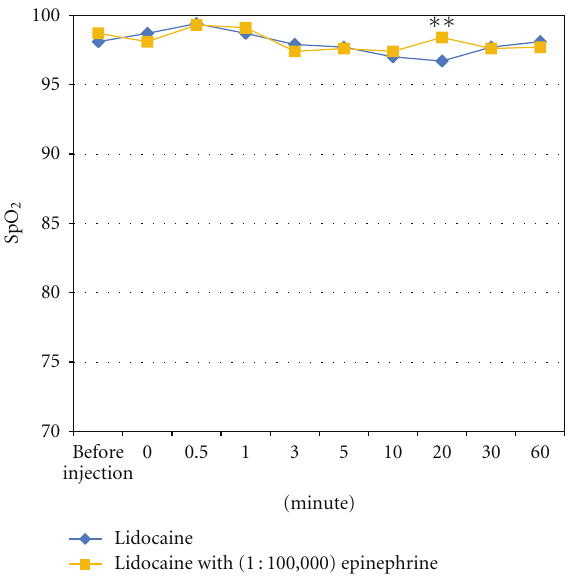
Figure 3: Transitional change of SpO 2 after a subcutaneous single injection at the middle point of the palmar digital crease. ∗∗ P < 0 .